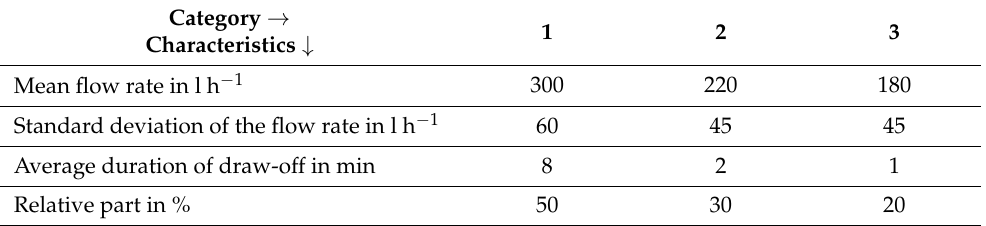
Table 7. Flow characteristics of the three domestic hot water draw-off